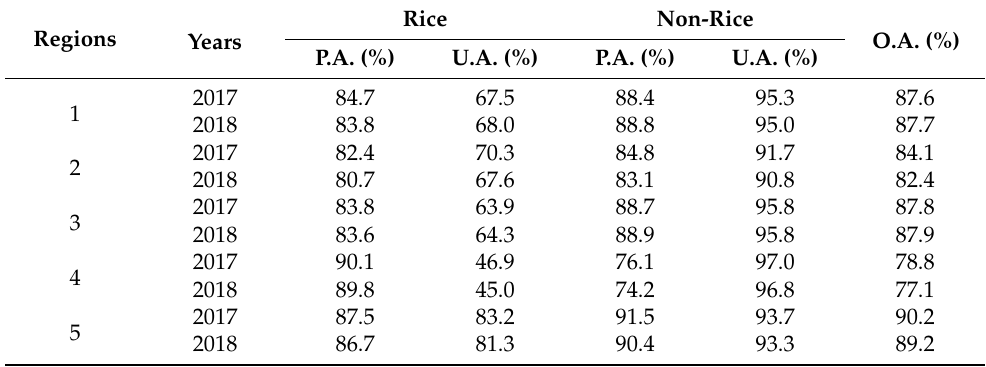
Table 9. Detection accuracy in 2017 and 2018 by the proposed method for VH polarization with ascending orbit